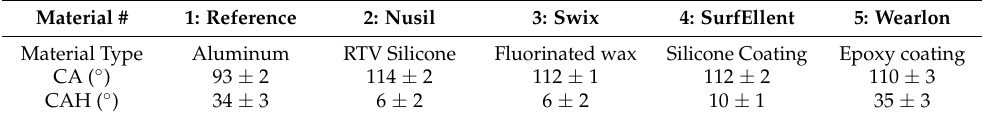
Table 1. Wettability